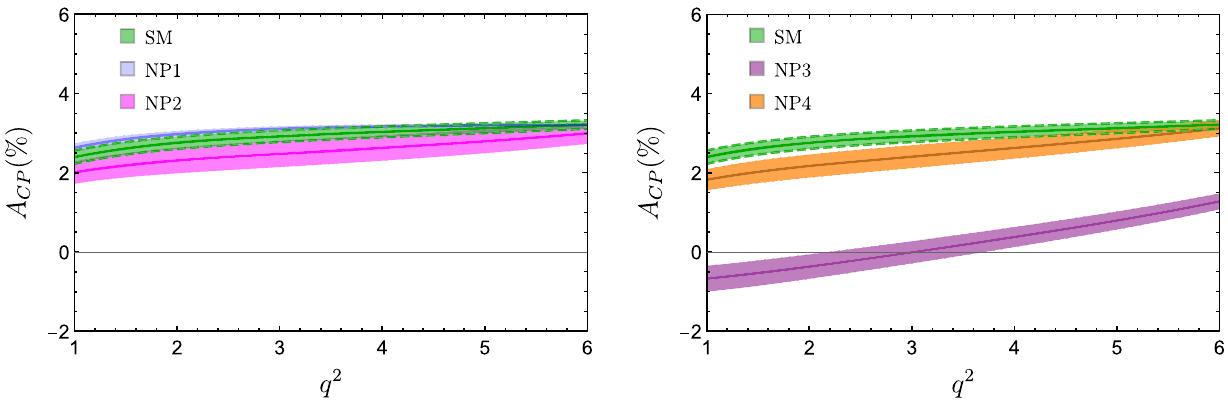
Fig. 7 Predictions for the direct CP asymmetry A CP ( q 2 ) in B s → ¯ K ∗ μ + μ − decay for benchmark scenarios with real couplings (left) and complex couplings (right)